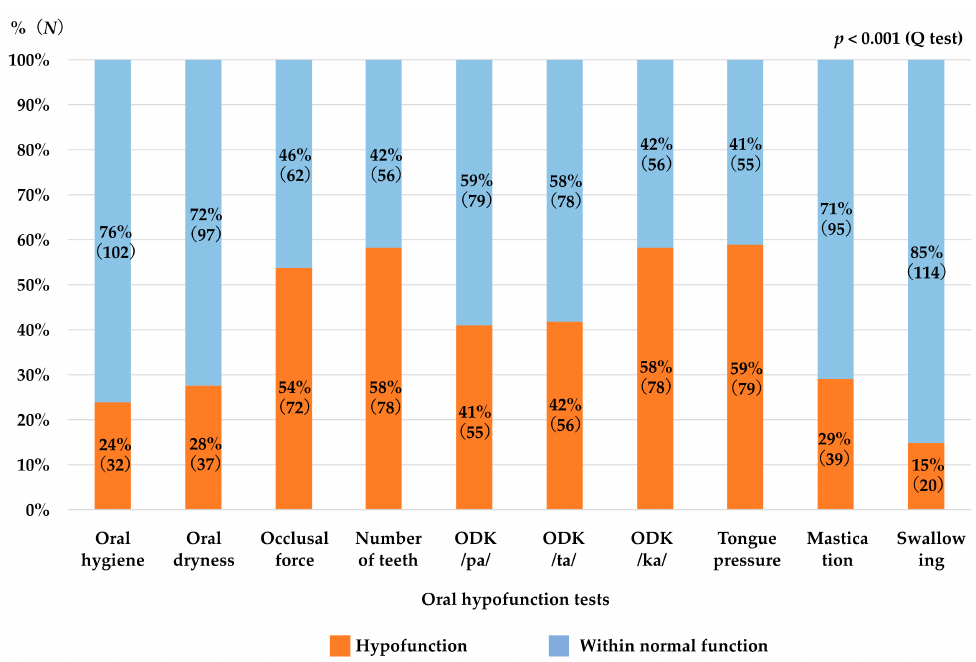
Figure 2. The rate of hypofunction diagnosed with the current reference value in oral hypofunction tests. The rate of hypofunction varied significantly between tests ( p < 0.001, Q test).